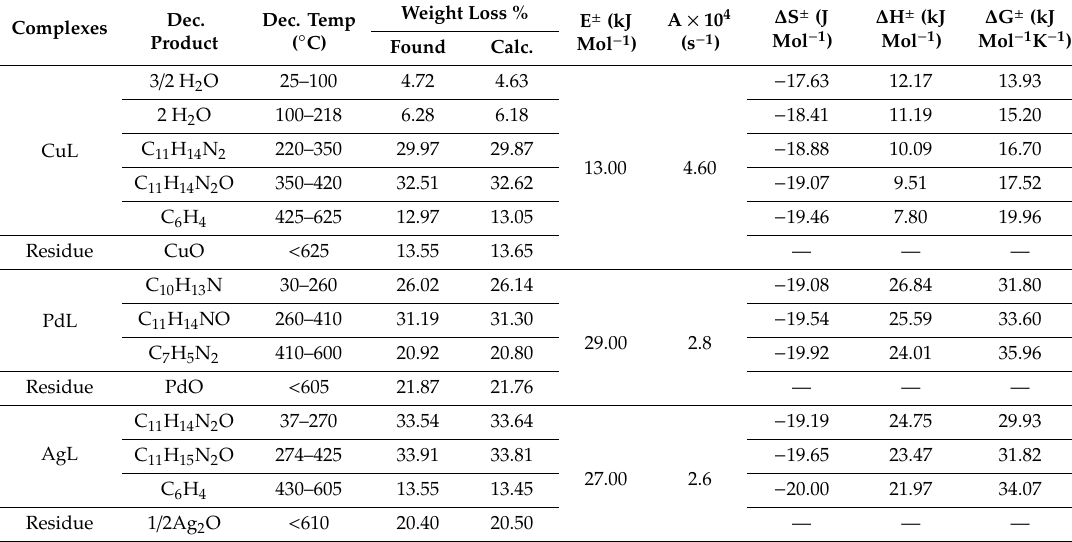
Table 3. TGA and the kinetic parameters of the prepared complexes.